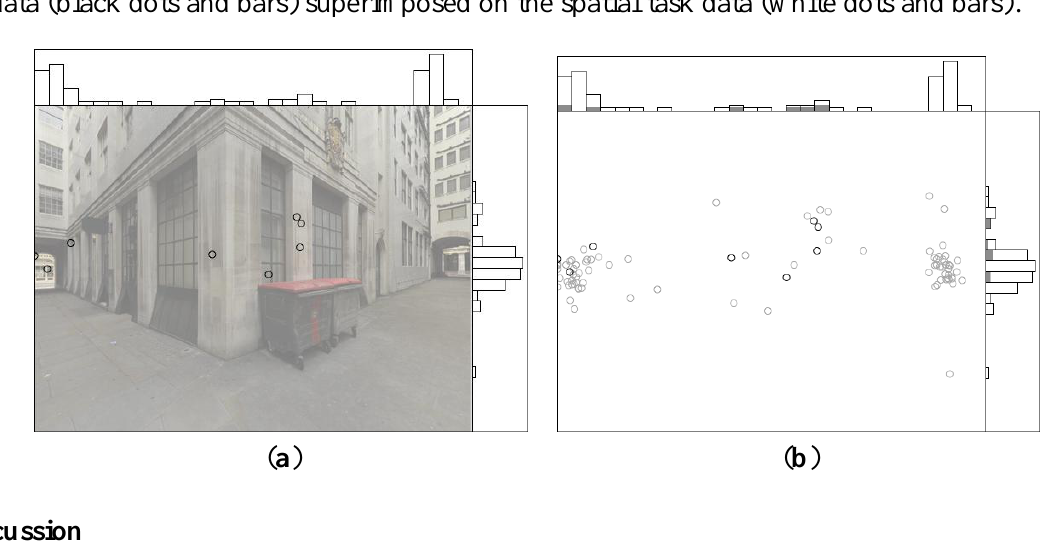
data from all participants for one stimulus. ( a ) Recall task fixations only. ( b ) Recall task data (black dots and bars) superimposed on the spatial task data (white dots and